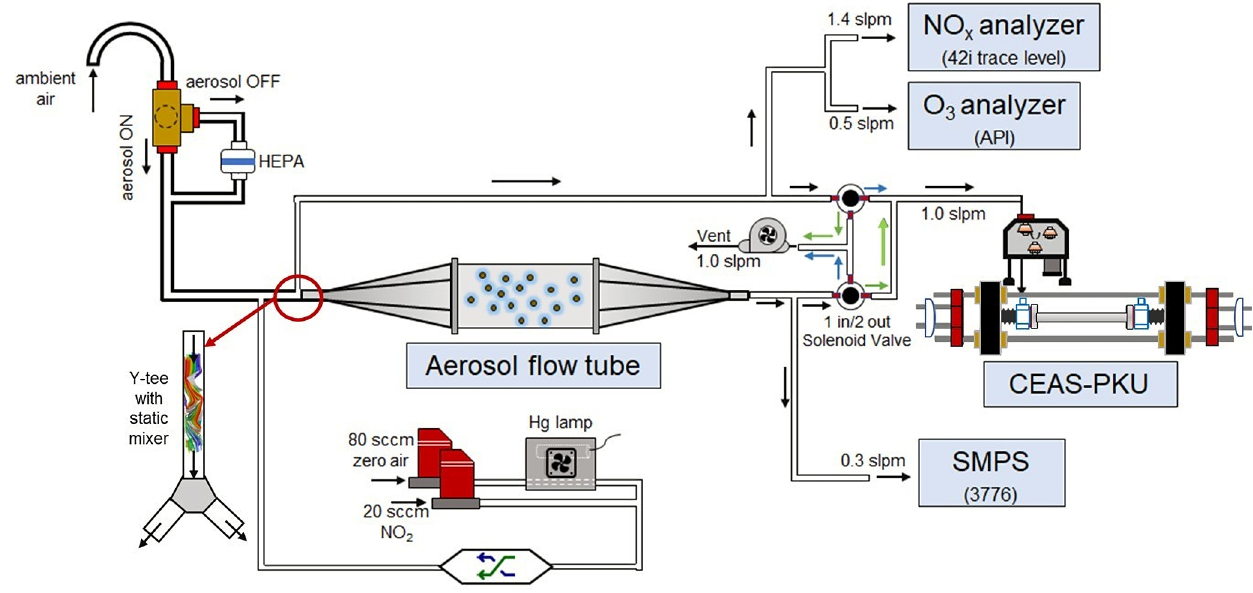
Figure 1. Overall schematic of aerosol flow tube system. The arrows alongside the tube show the flow directions. The black arrows indicate the flow directions consistent during the measurements, green arrows indicate the flow directions active in measuring the exit N 2 O 5 and blue arrows indicate the flow directions active in measuring the inlet N 2 O 5